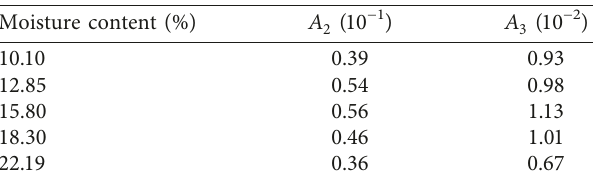
Figure 7: Three phases of swelling process. Table 1: Coefficients of primary swelling and secondary swelling with dry density of 0.14kN/m 3 .